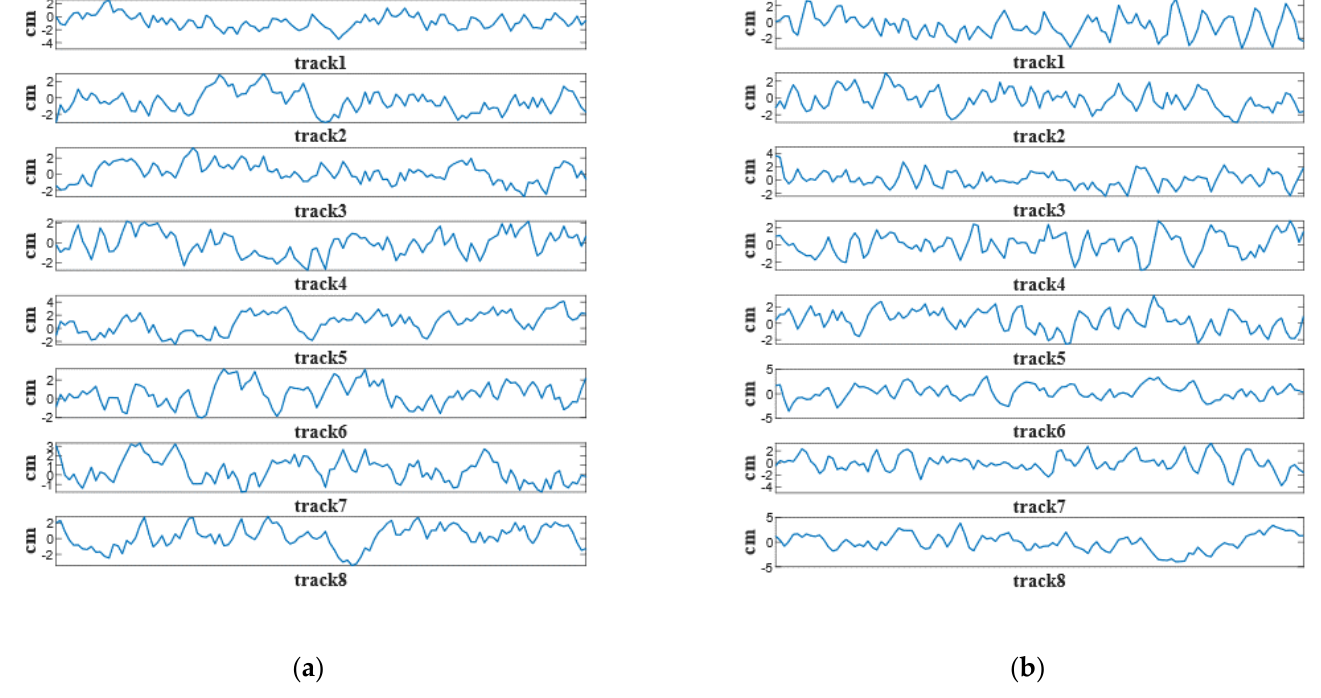
Figure 9. The lateral deviations controlled by ( a ) EfiMPC, and ( b ) NMPC in different